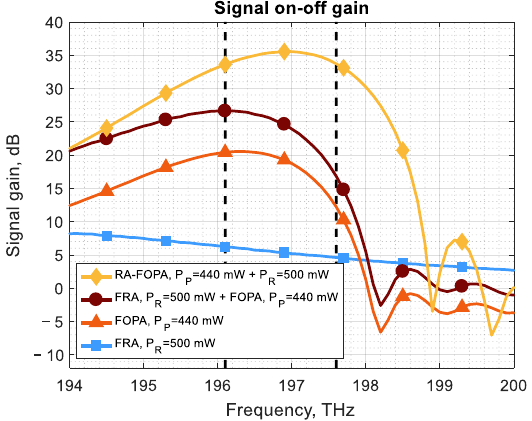
Figure 2. Signal on-off gain curves in the 194–200 THz frequency band for different amplifier combinations. The two vertical black dashed lines represent the frequency band in which all the 16 WDM channels are located.